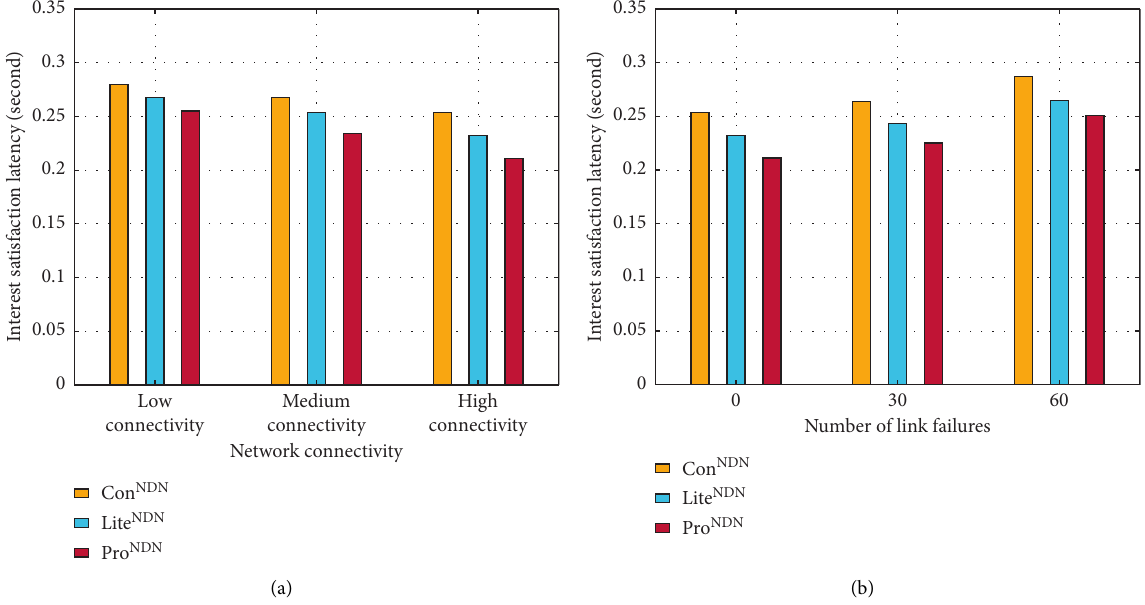
Figure 8: The performance of Interest satisfaction latency against network connectivity and number of link failures.